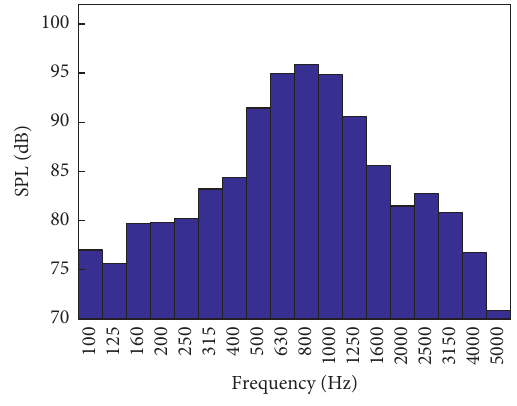
Figure 3: 1/3 octave spectrum.